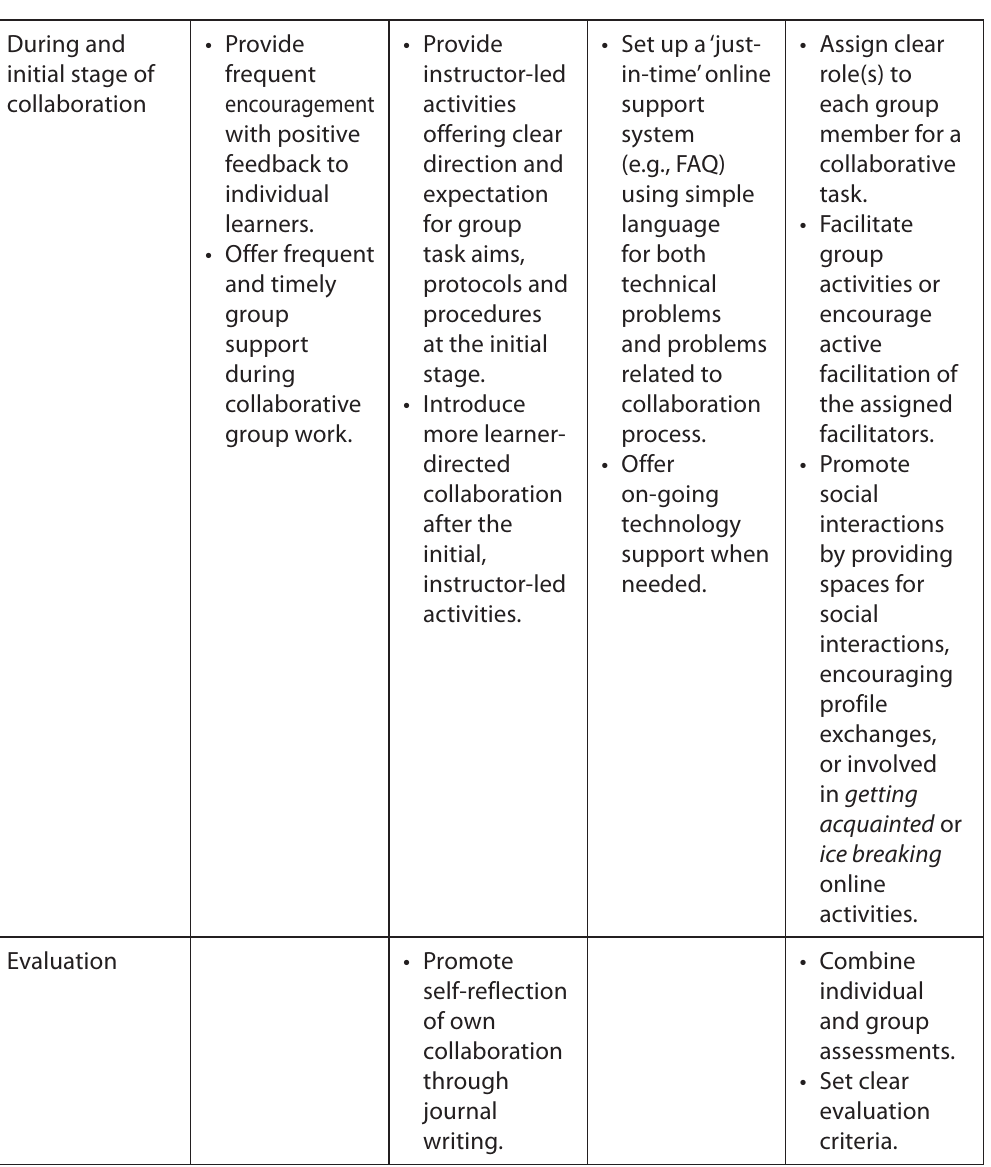
Table 1 Strategies to reduce stress of Asian learners in a high context culture in online collaboration using a foreign